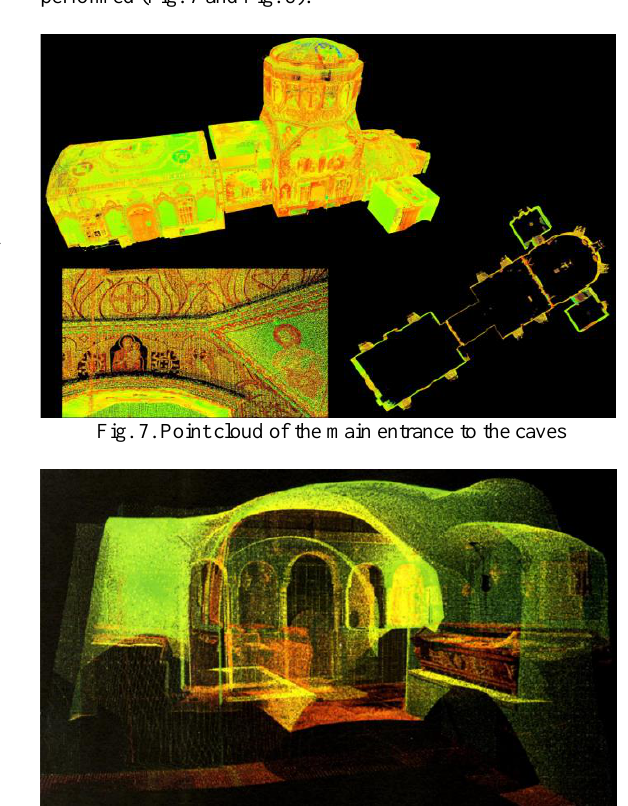
Fig. 8. A sample of point cloud after